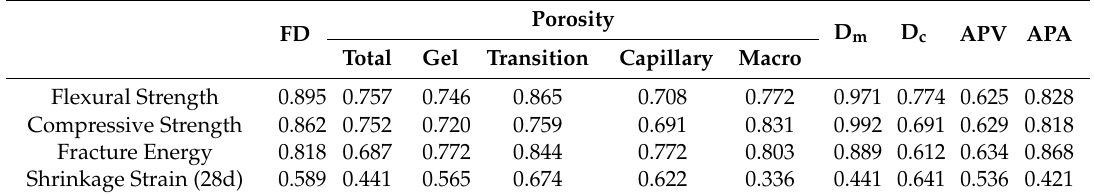
Figure 16. Relationship between D m with ( a ) compressive strength; ( b ) flexural strength; ( c ) fracture energy.